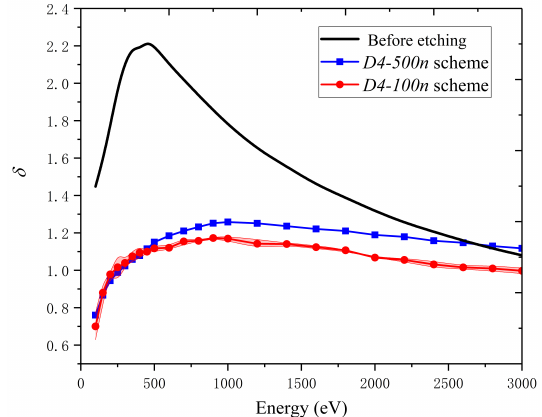
Figure 5. The sketch of SEY measurement system.